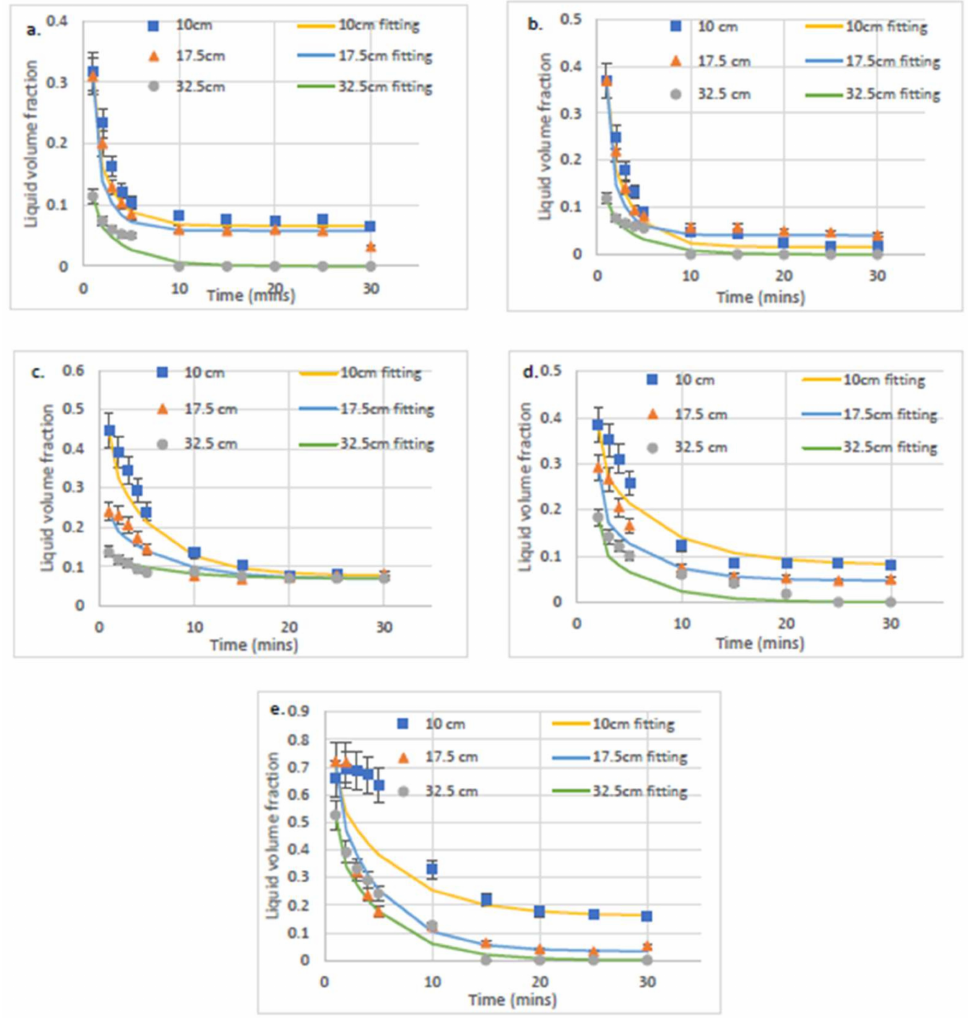
Figure 10. Dependency of liquid volume fraction with time of foam at each height for SDS solutions diluted with distilled water with concentrations ( a ) 0.5 CMC, ( b ) 1 CMC, ( c ) 10 CMC, ( d ) 20 CMC, and ( e ) 50 CMC. The fitting is according to Equation